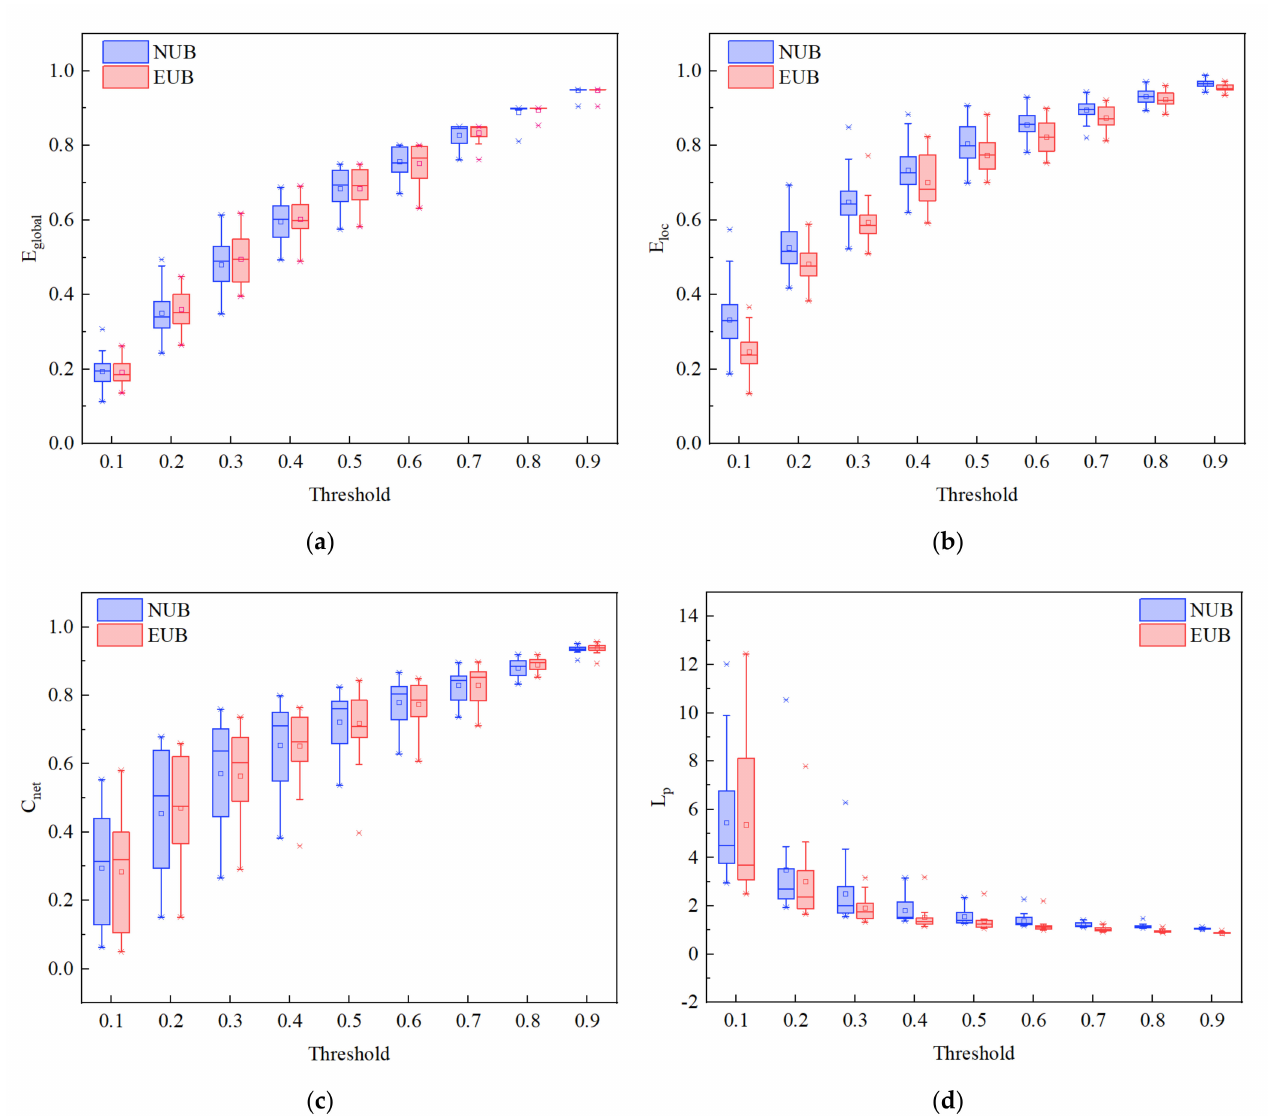
Figure 5. Comparison of the NUB brain network to the EUB brain network: network efficiency. ( a ) The global efficiency ( E global ). ( b ) The local efficiency ( E loc ). ( c ) The clustering coefficient ( C net ). ( d ) The characteristic path length ( L p ). The blue color represents NUB anticipation, and the red color represents EUB anticipation. The horizontal axes show the threshold values ( T ∈ (0.1:0.1:0.9)) and the vertical axes show the network properties indexes ( p <